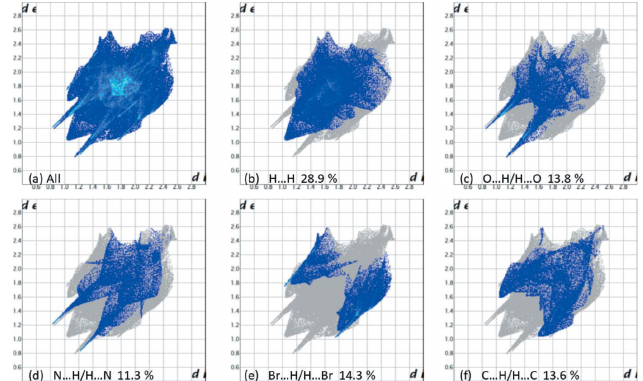
Figure 9 The full two-dimensional fingerprint plot for compound (I), and